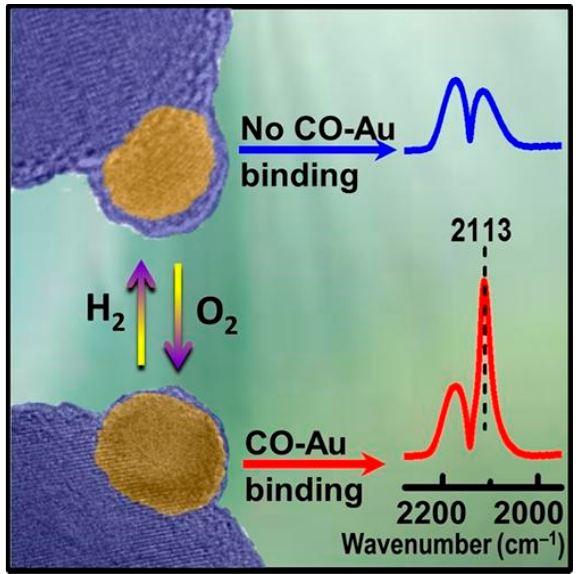
Figure 9. Schematic illustration of the classical SMSI phenomenon in Au/TiO 2 . Reproduced with permission from [48], copyright: 2017 by the American Association for the Advancement of Science.